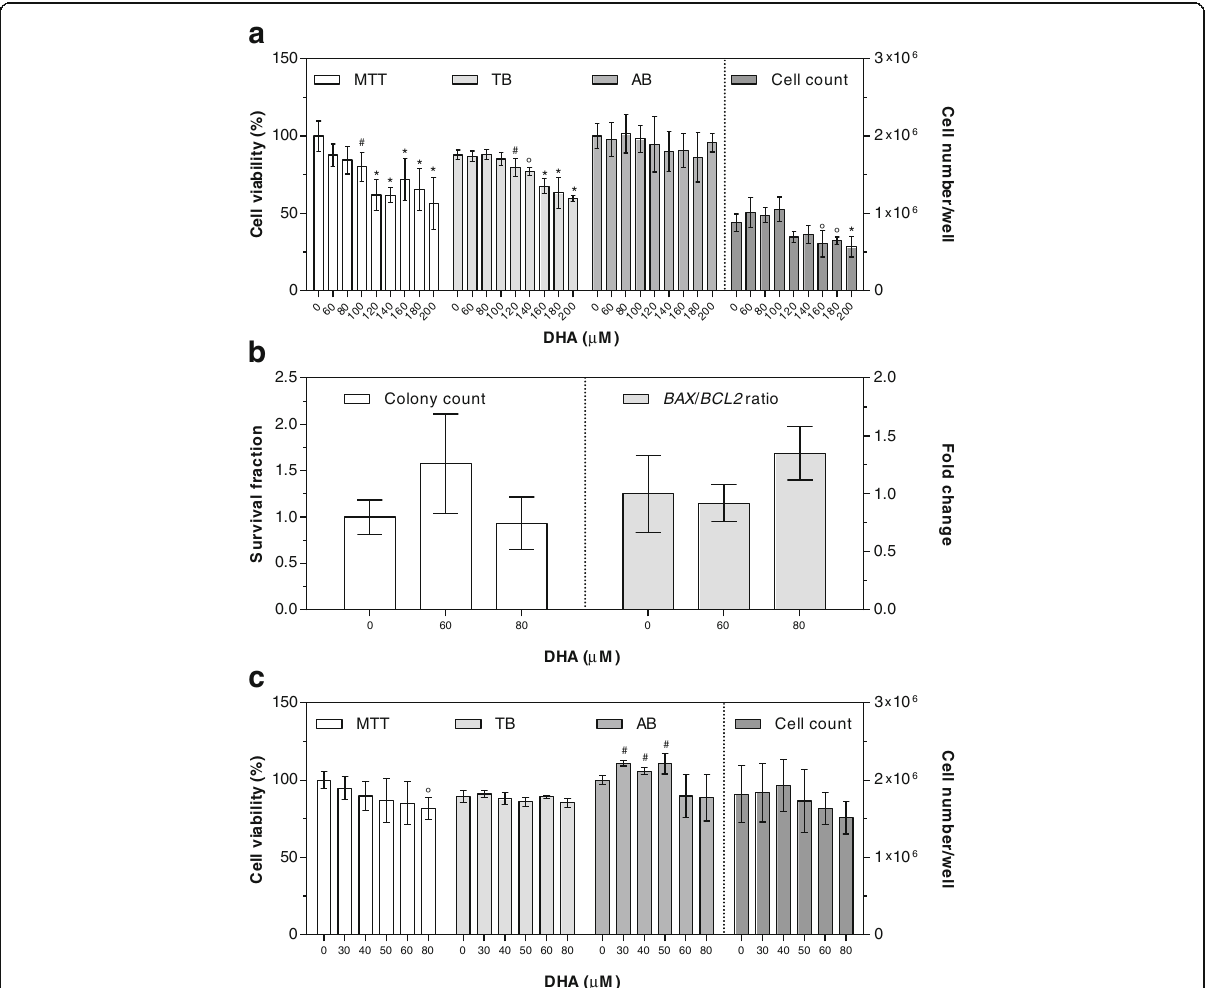
Fig. 1 Cytotoxic effects of DHA after 24 ( a , b ) and 48 ( c ) hours of supplementation. Cell viability by MTT and AB is expressed as percentage of control cells (assigned as 100%). TB is expressed as percentage of total cells. Cell count is expressed as number of cells per well. Colony count by clonogenic assay is expressed as survival fraction. BAX/BCL2 gene expression ratio is expressed as the mean fold change of relative expression compared to control cells, normalized to one. Data are means ± SD of six samples obtained from two independent experiments. Statistical analysis was by the one-way ANOVA (panel a : MTT and cell count p < 0.001, TB p < 0.05, AB n.s.; panel b : colony count n.s., BAX/BCL2 ratio n.s.; panel c : MTT, TB, and AB p < 0.05, cell count n.s.) using Dunnett ’ s as post-test to compare supplemented cells to control ones (# p < 0.05; ° p < 0.01; * p <